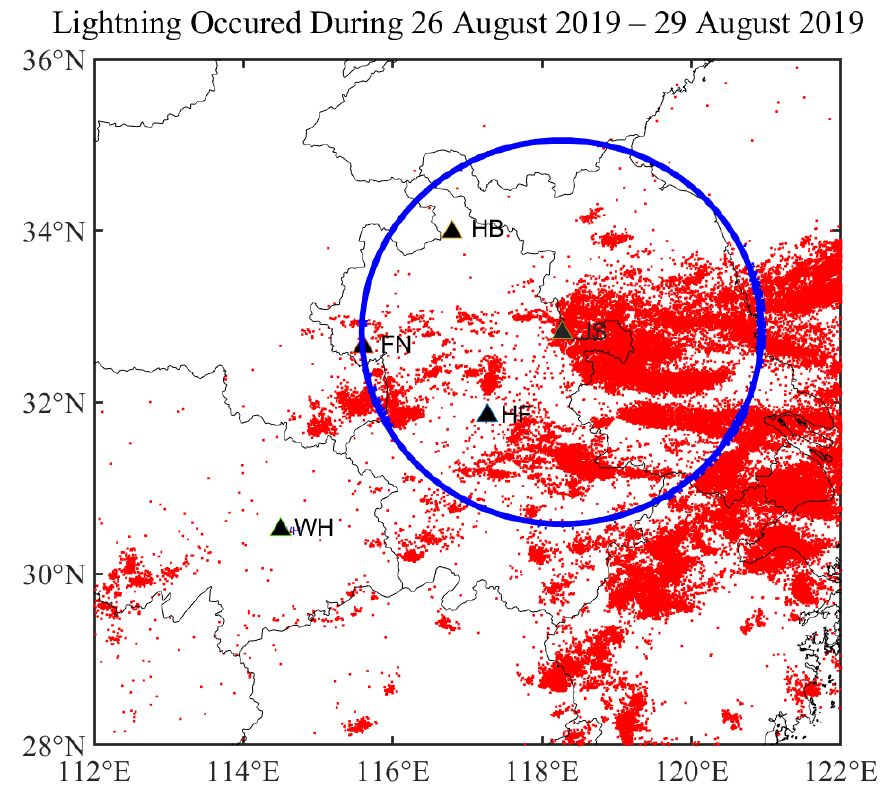
Figure 6. Map of the lightning events detected by the JASA from 26 August 2019 to 29 August 2019. The blue circle highlights the lightning that occurred at a distance of 200–210 km from the JS station.